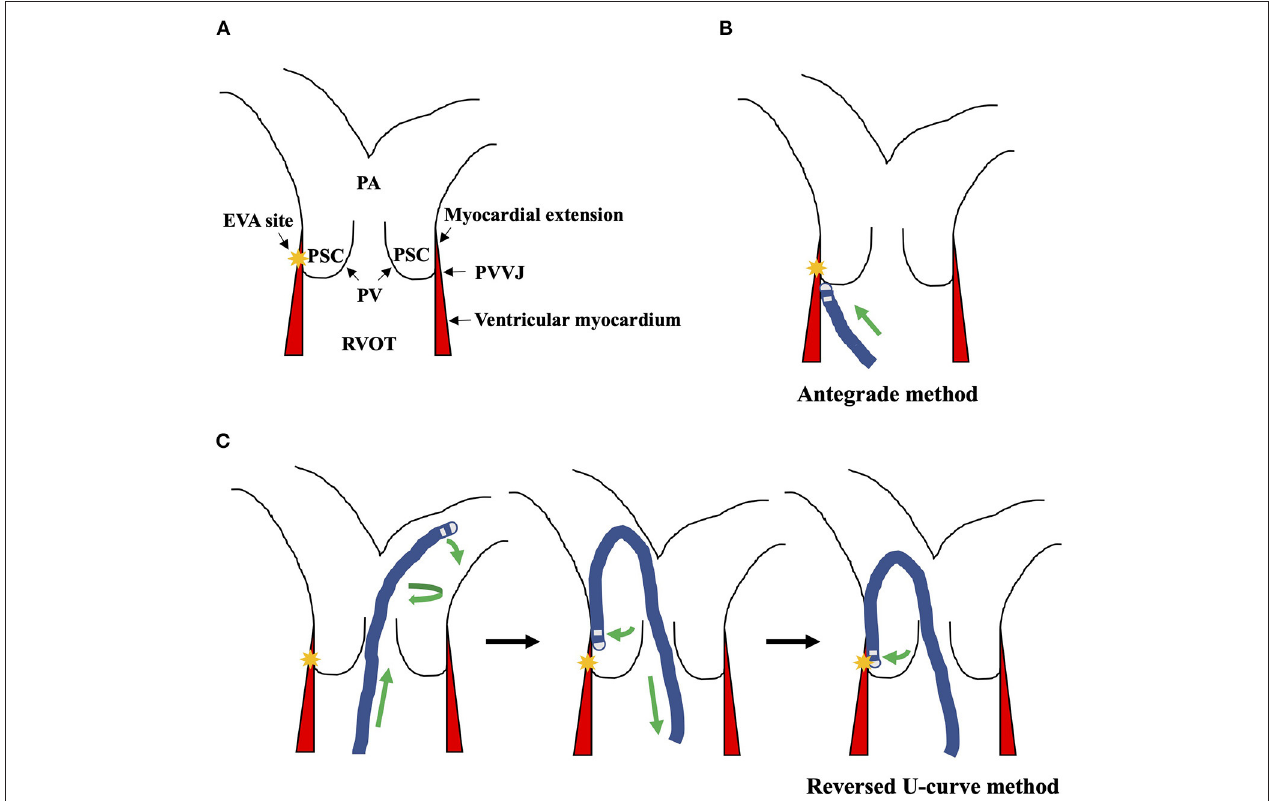
FIGURE 2 | Illustration of the anatomy and the ablation strategies. (A) The PVVJ was where the PVs adhere to the ventricle wall. The myocardial extensions were the ventricular musculatures that extended above the PVVJ. The yellow star indicated the EVA site. (B) Targeting the EVA site with the antegrade method. (C) The reversed U-curve was created in the bifurcation of PA by curving, advancing, and torquing the ablation catheter. Then, the reversed U-curve was loosened to contact the PA wall and retracted into PSC to engage the EVA site. EVA, earliest ventricular activating; PA, pulmonary artery; PSC, pulmonary sinus cusp; PV, pulmonary valve; PVVJ, pulmonary valve–ventricle junction; RVOT, right ventricular outflow tract; VA, ventricular arrhythmia.